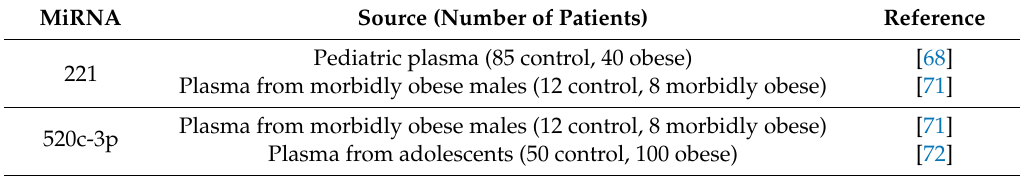
Table 2. Circulating miRNAs which were reproducibly decreased in obesity.